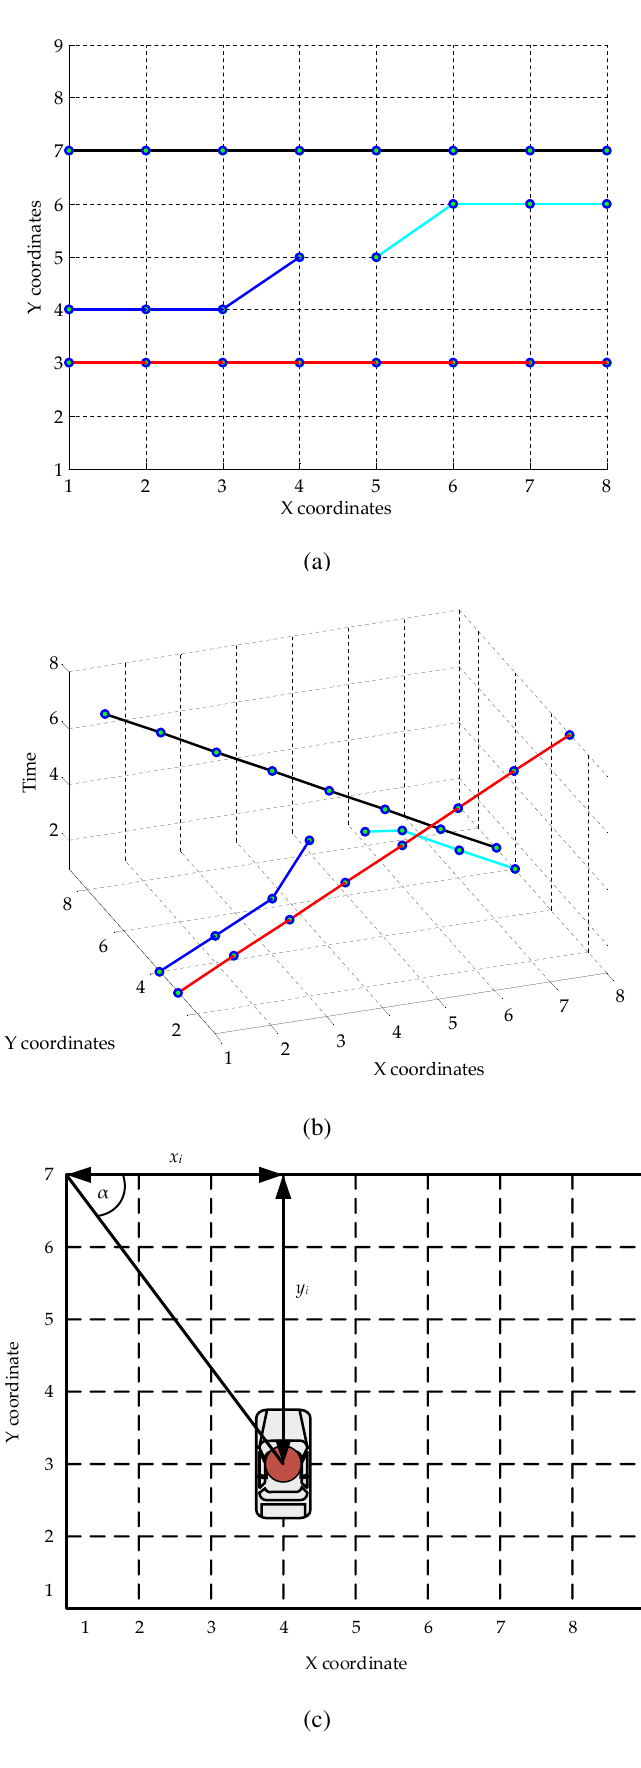
Figure 2. The object trajectory: ( a ) in the spatial dimension ( b ) in the temporal-spatial dimension; and ( c ) the direction of motion